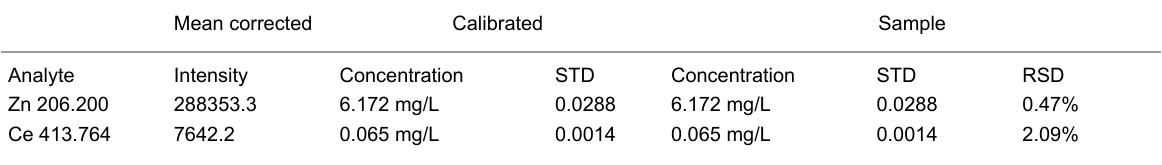
Table 3: ICP-MS data of Zn and Ce in the CZO-4 sample. Standard deviation (STD), relative standard deviation